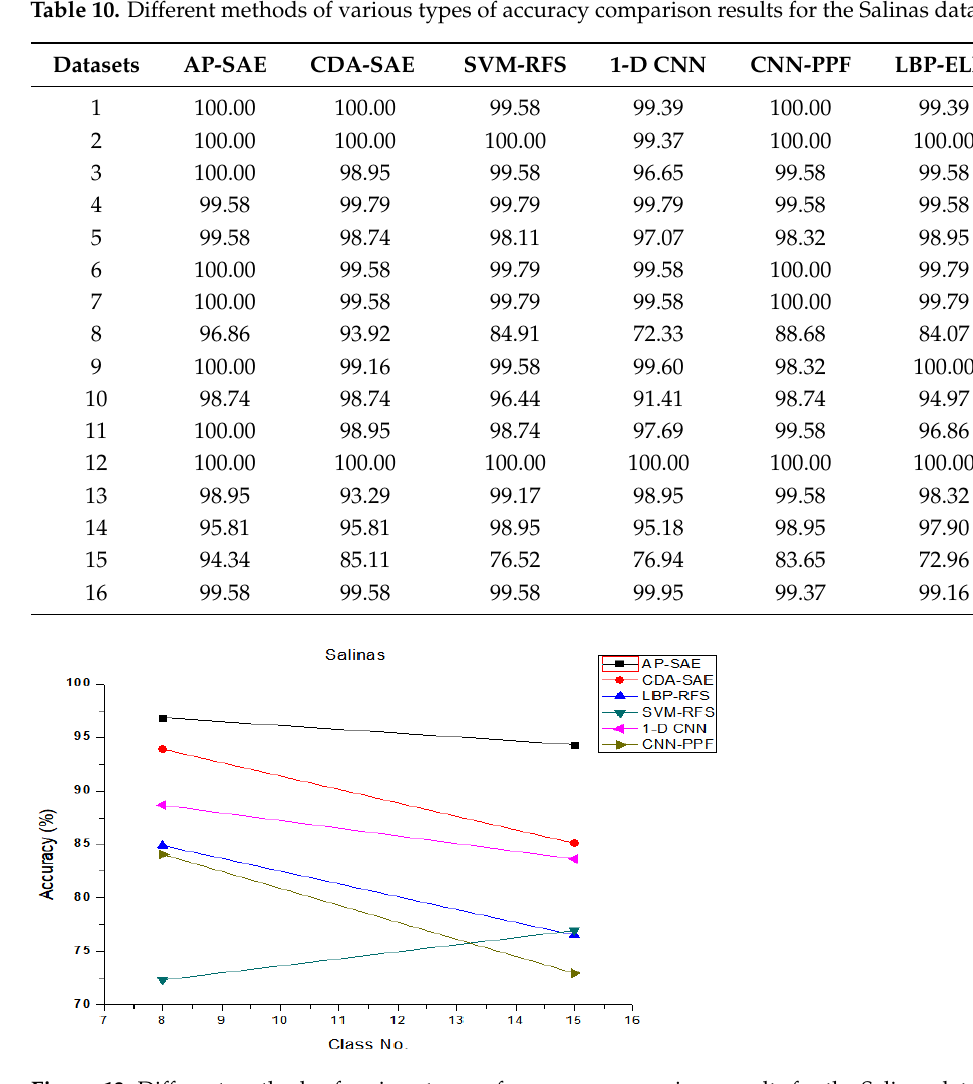
Figure 13. Different methods of various types of accuracy comparison results for the Salinas